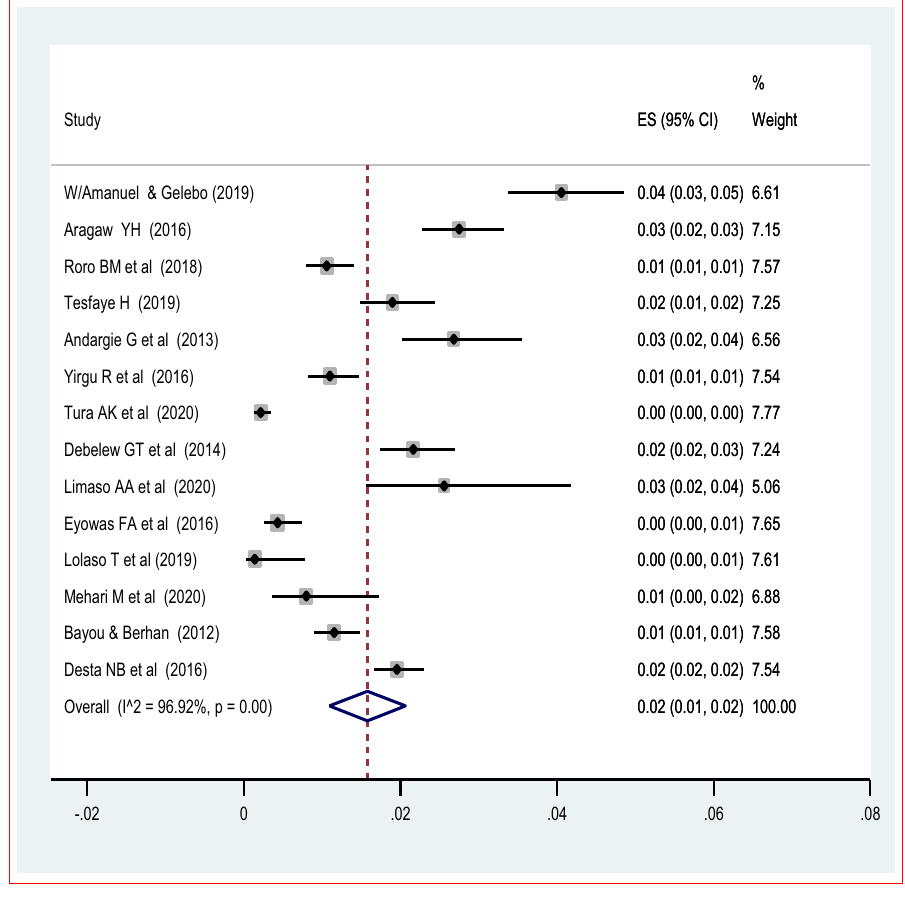
Figure 3. Forest plot on the pooled prevalence of early neonatal death in Ethiopia: